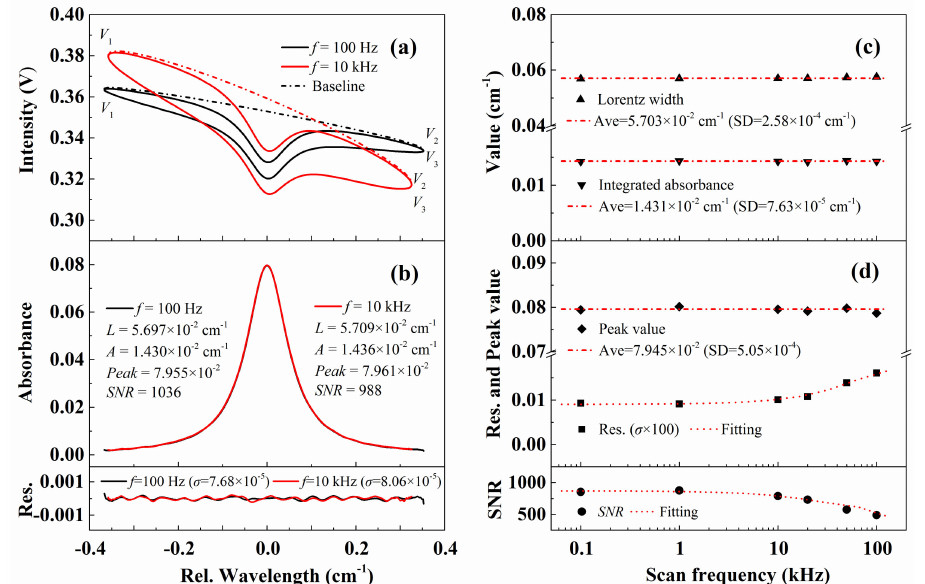
Figure 6. The recovered light intensity ( a ) and the best-fit absorbance ( b ) with di ff erent scan frequencies of 100 Hz and 10 kHz. ( c , d ) The best-fit parameters including the Lorentz width, integrated area, peak value, standard deviation of residual and SNR with di ff erent scan frequencies. The experimental conditions are: CO / N 2 mixture gas, T = 299 K, L = 14.7 cm, X co = 1.53%, P = 100.6